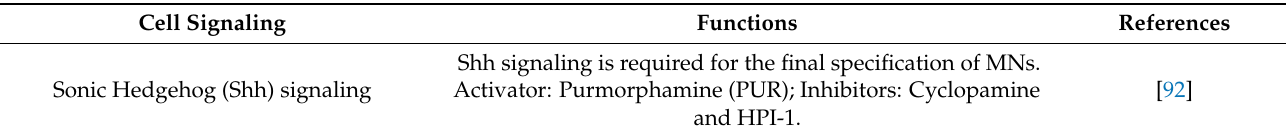
Table 2. Signaling pathways participating in MN